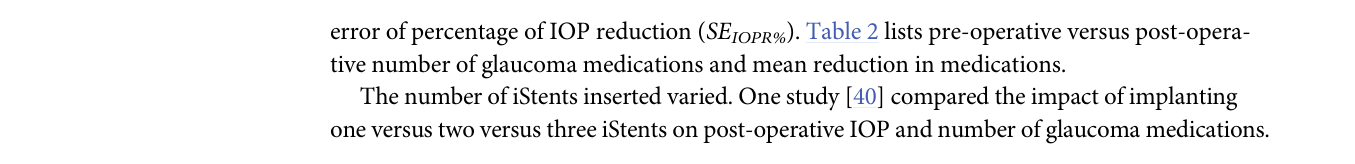
error of percentage of IOP reduction ( SE IOPR% ). Table 2 lists pre-operative versus post-opera- tive number of glaucoma medications and mean reduction in medications. The number of iStents inserted varied. One study [40] compared the impact of implanting one versus two versus three iStents on post-operative IOP and number of glaucoma medications.